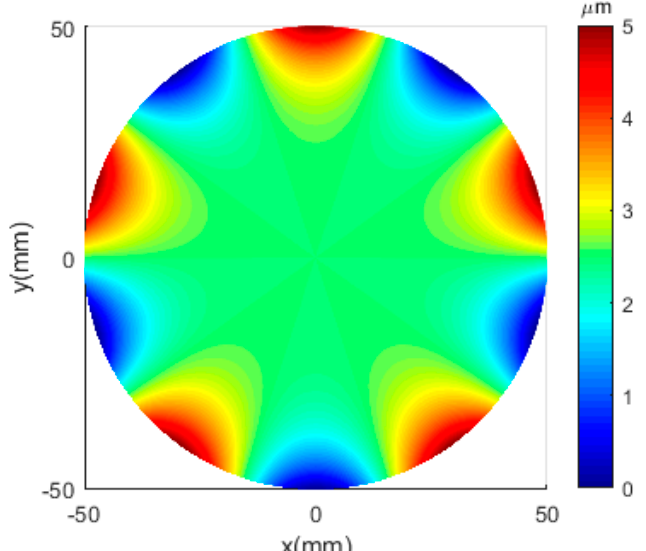
Figure 14. Five-leaved error surface shape.